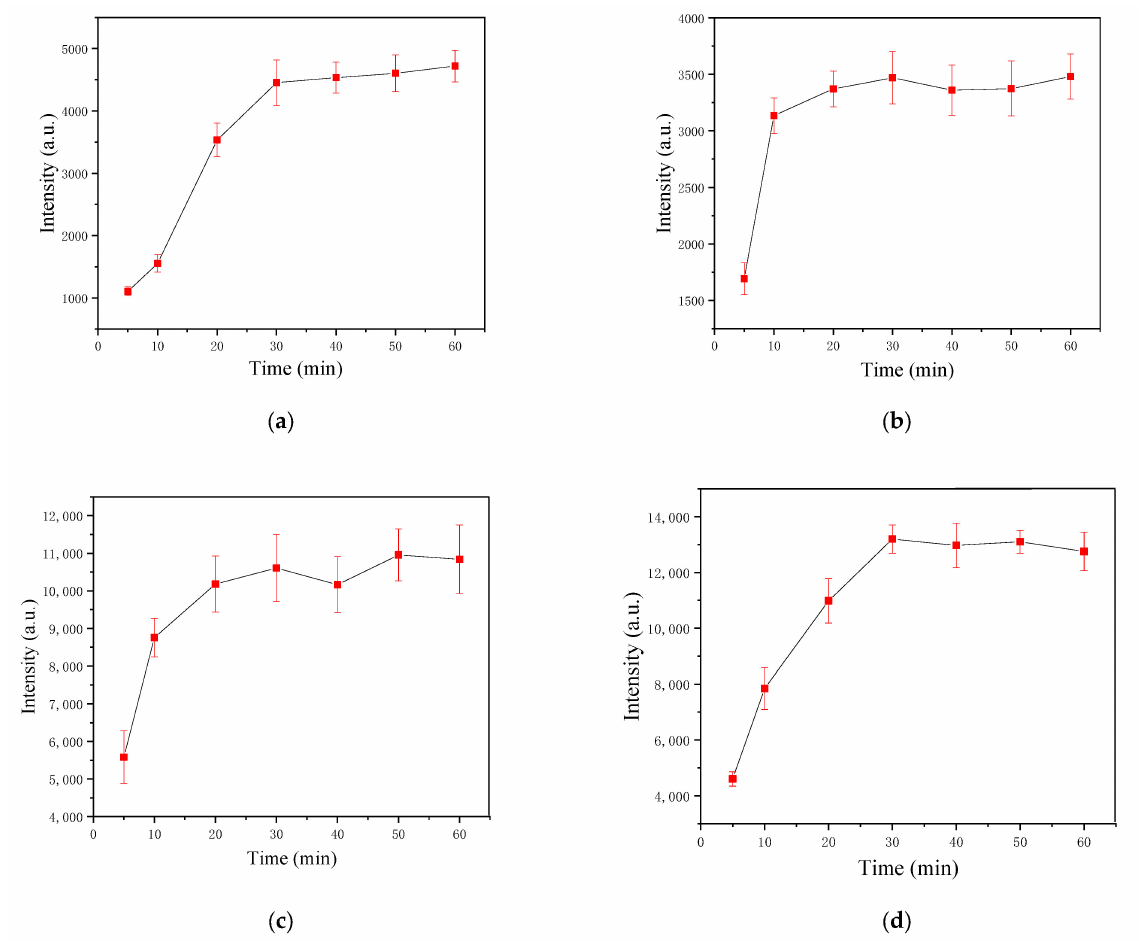
Figure 7. Optimization of enrichment time on the emission of ( a ) Cr; ( b ) Cu; ( c ) Pb; and ( d )